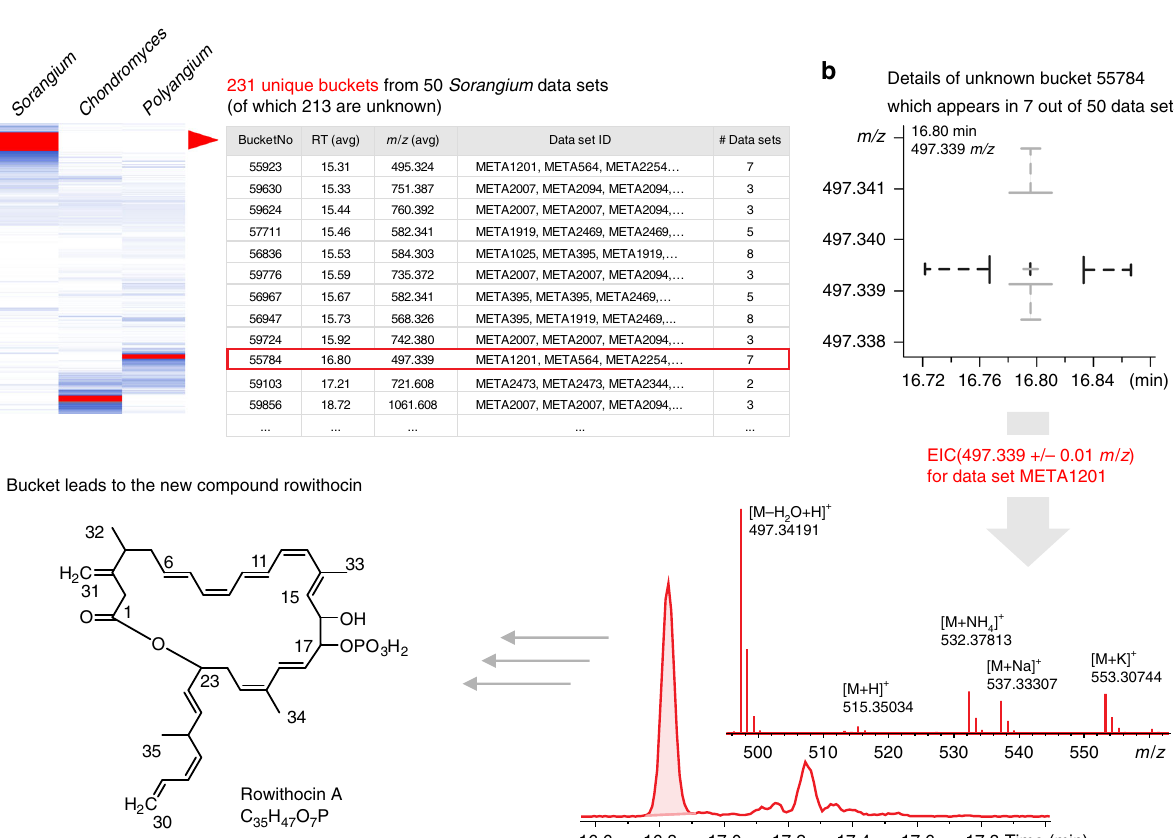
Fig. 6 Discovery of the new myxobacterial natural product rowithocin. a Section of the heatmap featuring unique buckets from Sorangium . More than 200 buckets are found exclusively within the 50 Sorangium data sets. b Information on each bucket allows interpretation of the bucket ’ s characteristics such as median, quantile and outlier analysis. c Investigation of an unknown bucket with 497.339 m / z around 16.8 min revealed that the bucket corresponds — besides several adduct ions — to a distinct signal of type [M + H] + with 515.350 m / z . Subsequent analyses of newly prepared extracts revealed